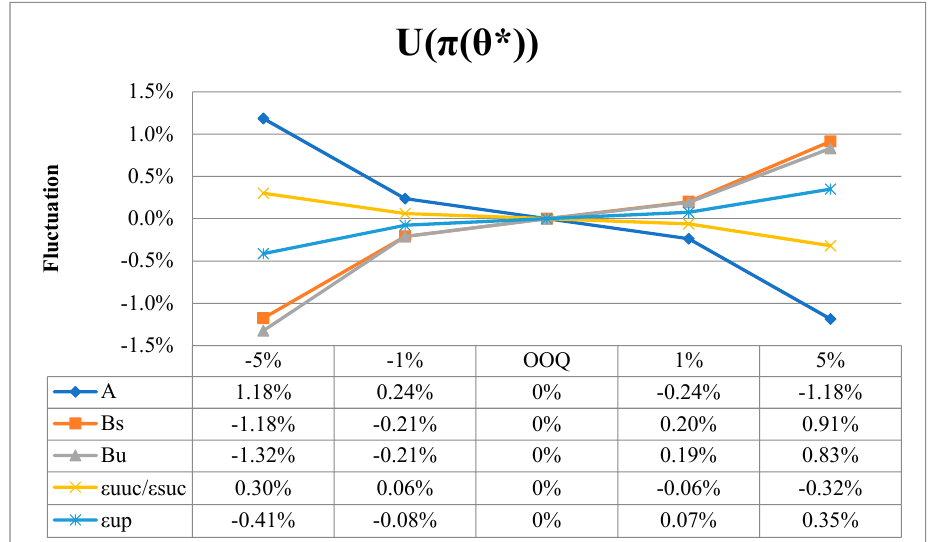
Figure 3. Sensitivity analysis of parameter changes for the utility function.